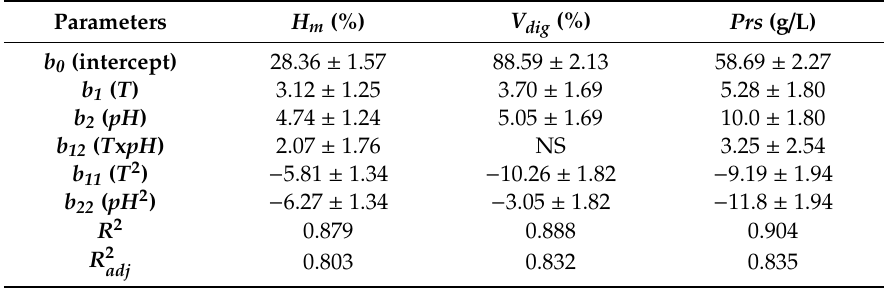
Table 1. Polynomial equations describing the combined effect of temperature ( T ) and pH on Alcalase hydrolysis of Tu_H. The coefficient of determination and adjusted determination ( R 2 and R 2 ) and F-values are also shown. NS: non-significant. Optima values of the two variables ( T opt , pH opt ) to achieve the theoretical maximum responses ( Y max ) from the empirical equations were also calculated. S: significant; NS: not significant.